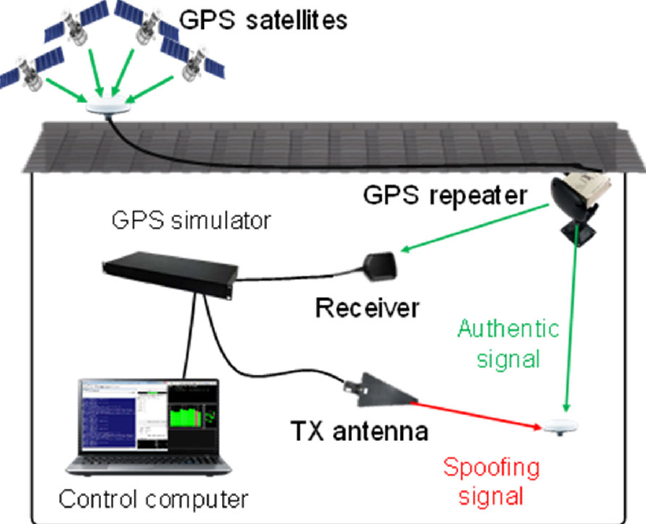
Figure 5. GPS spoofing signal simulation environment.